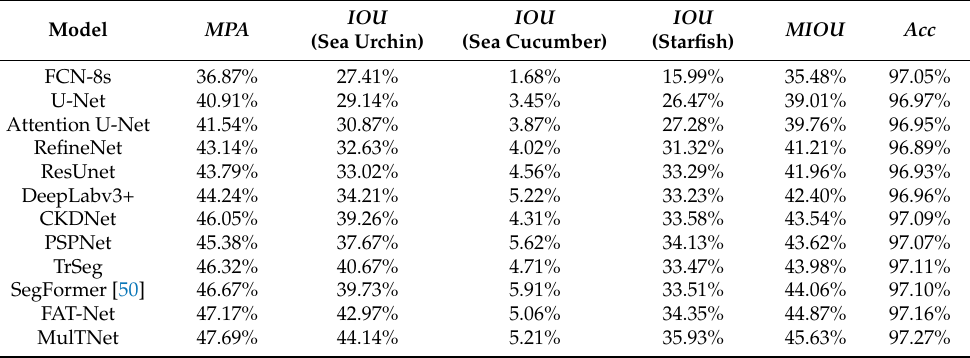
Table 3. Comparison of various segmentation networks for the marine animal